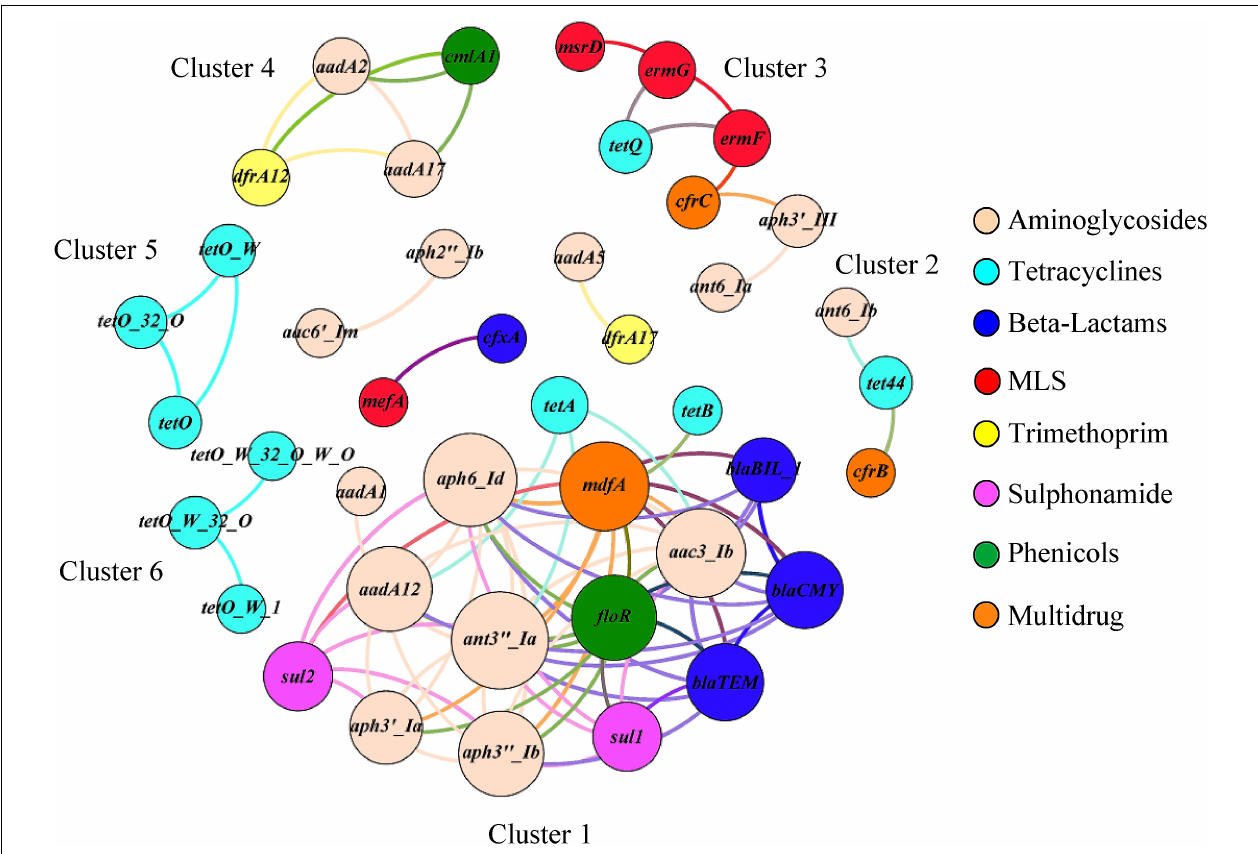
FIGURE 5 | The co-occurrence network among ARG families in veal calf feces. The nodes (ARG families) were colored by the corresponding class of antimicrobials and the size of each node represents the number of connections or edges (degree). An edge represents a strong (Spearman ρ ≥ 0.8) and significant ( p < 0.01) correlation between two ARG families and edges were colored according to their connecting nodes for better